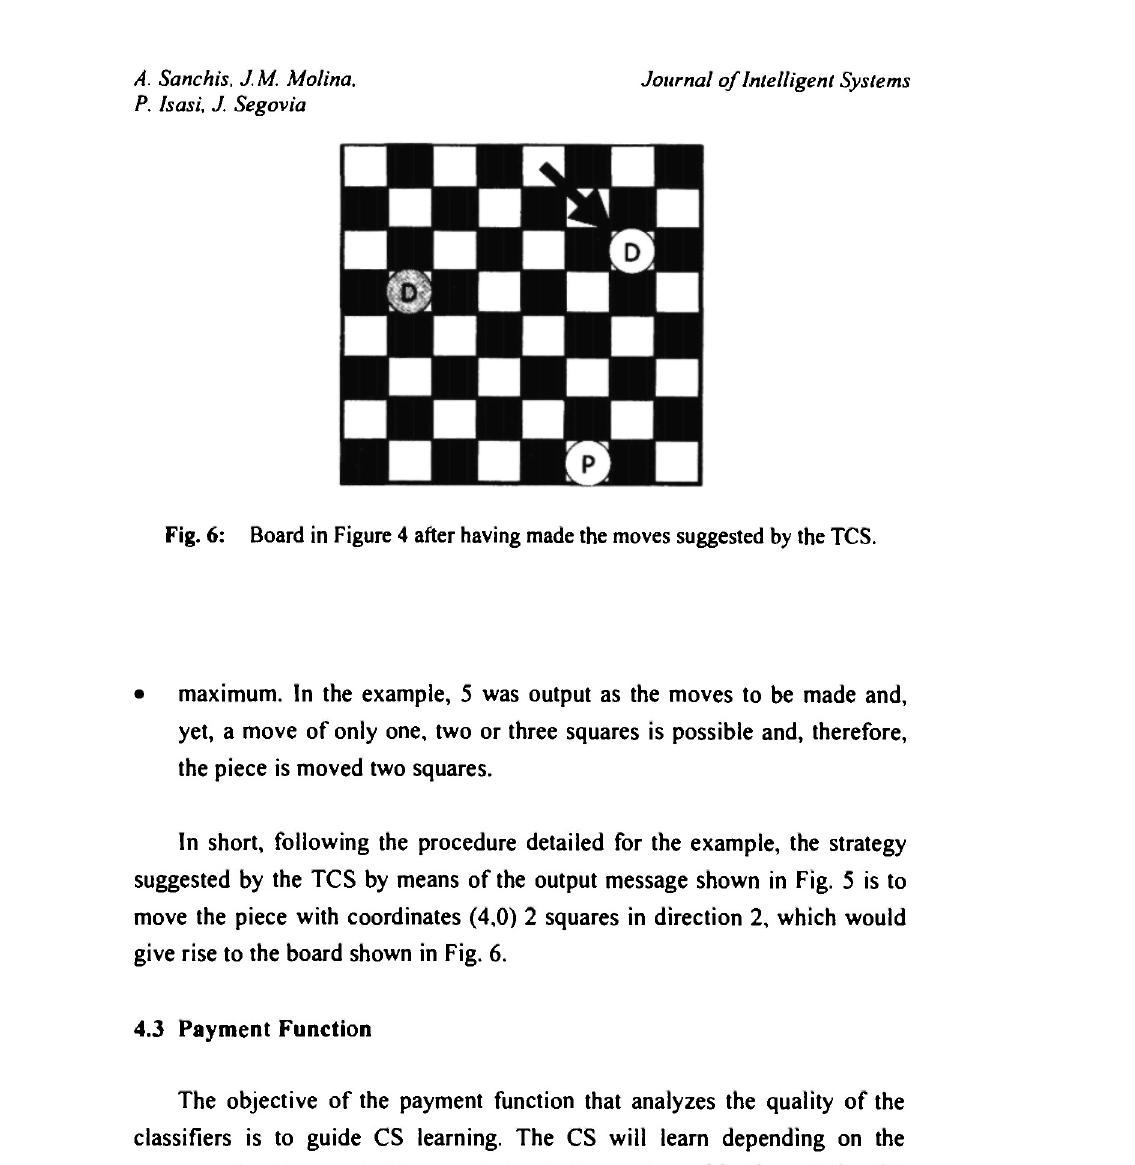
Fig. 6: Board in Figure 4 after having made the moves suggested by the